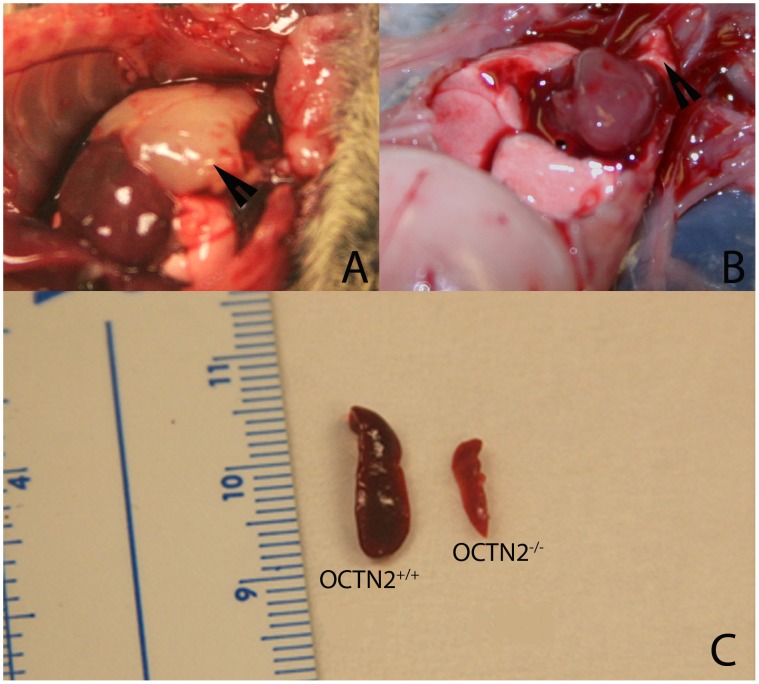
Gross appearance of thymus and spleen.Panel A is an image of OCTN2+/+ mouse thymus covering the heart (Arrowhead), and panel B is an image of OCTN2−/− mouse thymus above the heart (Arrowhead). Panel C is an image of age-matched OCTN2+/+ (left) and OCTN2−/− (right) mouse spleens.